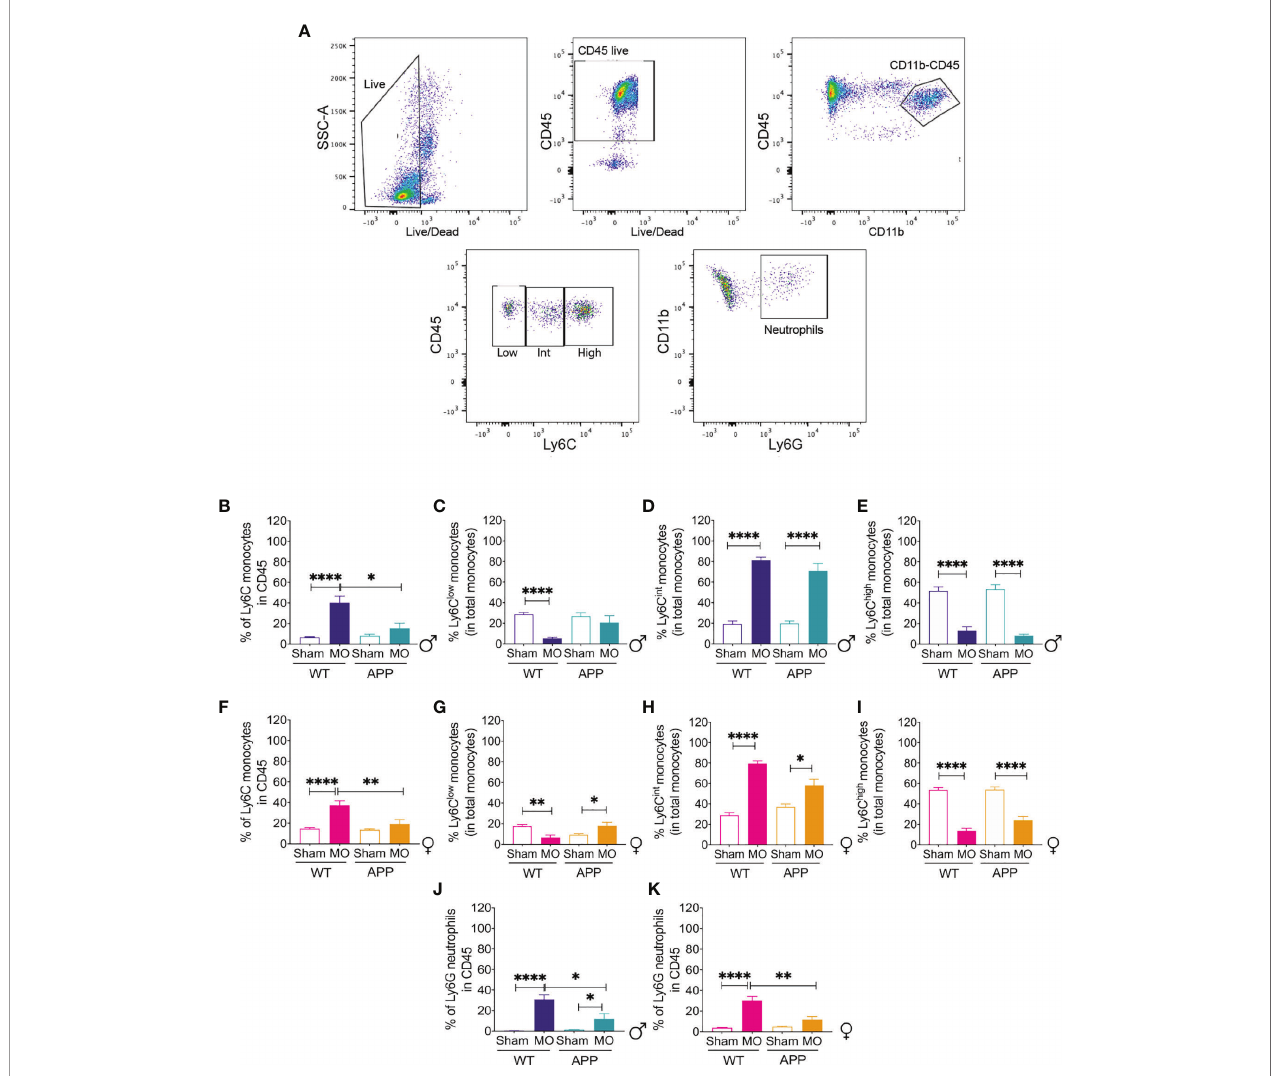
FIGURE 7 | Dynamics of circulating monocytes are modulated upon multifocal microinfarction. (A) Gating strategy used to discriminate the circulating monocytes (CD11b + LyC6 + ) in leukocytes (CD45 + ) and the subsequent distribution of the in fl ammatory monocytes (Ly6C high ), patrolling monocytes (Ly6C low ) and neutrophils (Ly6G high ). (B) Flow cytometry analysis shows that the frequency of total monocytes in the blood circulation increases in MO-operated male WT mice while it remains unchanged in MO-operated male APP/PS1 mice compared to sham-operated male mice and decreases in MO-operated male APP/PS1 mice compared to MO- operated male WT mice. (C) Flow cytometry analysis shows that the frequency of Ly6C low monocytes decreases in the blood circulation of MO-operated male WT mice compared to sham-operated WT mice. (D) Flow cytometry analysis shows that the frequency of Ly6C int monocytes increases in the blood circulation of MO- operated male WT mice as well as MO-operated male APP/PS1 mice compared to sham-operated WT mice. (E) Flow cytometry analysis shows that the frequency of in fl ammatory Ly6C high monocytes decreases in the blood circulation of MO-operated male WT mice as well as MO-operated male APP/PS1 mice compared to sham-operated male mice. (F) Flow cytometry analysis shows that similarly to males, the frequency of total monocytes in the blood circulation increases in MO- operated female WT mice while it remains unchanged in MO-operated female APP/PS1 mice compared to sham-operated female mice and decreases in MO- operated female APP/PS1 mice compared to MO-operated female WT mice. (G) Flow cytometry analysis indicates that the frequency of Ly6C low monocytes increases in MO-operated female WT mice, while it decreases in the MO-operated female APP/PS1 mice compared to sham-operated female mice. (H) Flow cytometry analysis indicates that the frequency of Ly6C int monocytes increases in the blood circulation of MO-operated female WT mice and to a lesser extent MO- operated female APP/PS1 mice. (I) Flow cytometry analysis indicates that the frequency of Ly6C high monocytes is decreased in the blood circulation of MO-operated female WT mice as well as MO-operated female APP/PS1 mice compared to sham-operated female mice. (J) Flow cytometry analysis shows that the frequency of Ly6G neutrophils increases in MO-operated male WT mice compared to sham-operated male WT mice but to a lesser extent in MO-operated male APP/PS1 mice compared to sham-operated APP/PS1 male mice. (K) Flow cytometry analysis shows that the frequency of Ly6G neutrophils similarly increases in the blood circulation of MO-operated female WT mice compared to sham-operated female WT mice, whereas it remains unchanged in MO-operated female APP/PS1 mice compared to sham-operated female APP/PS1 mice. Data are mean ± SEM (n = 5-10 animals/group). *P < 0.05/**P < 0.01/****P < 0.01 compared with sham- and MO-operated male and female WT and APP/PS1 mice (two-tailed unpaired